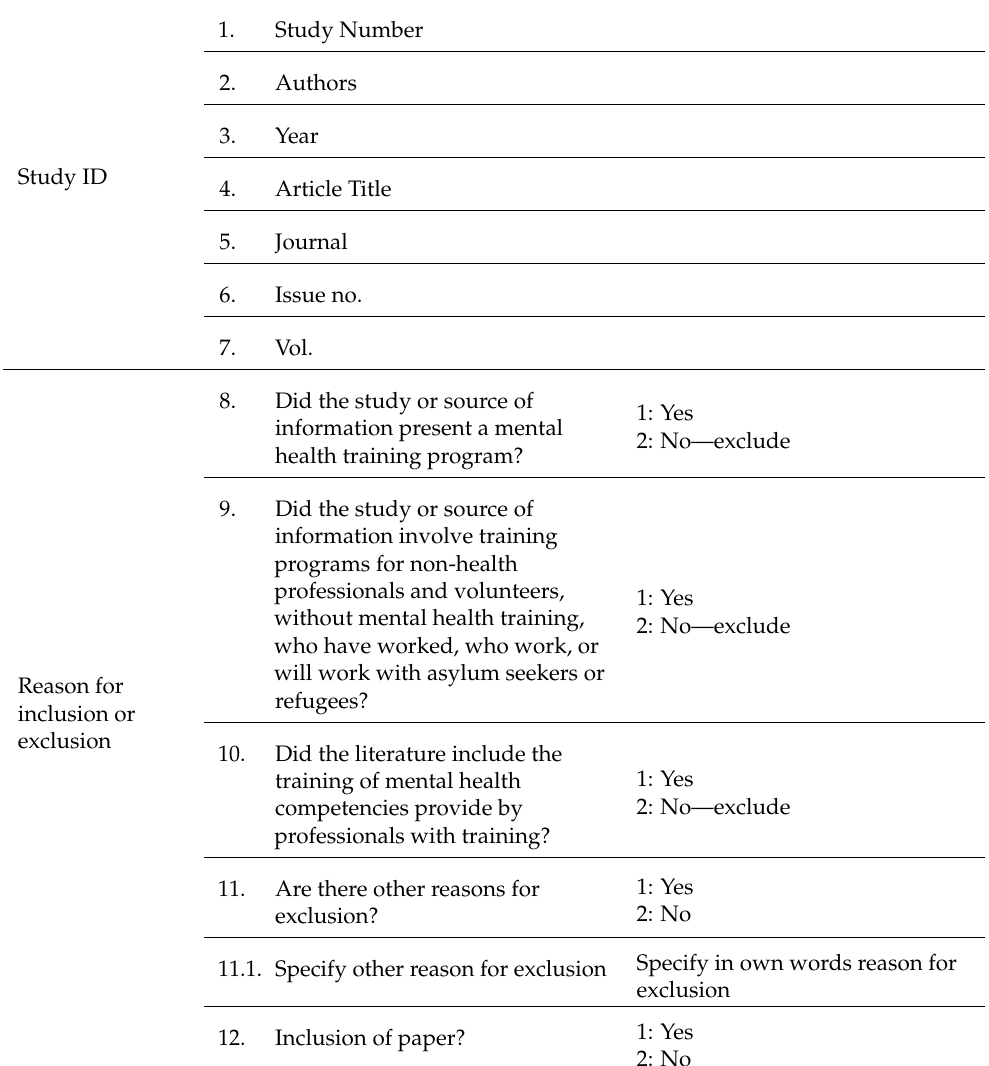
Table A2. Data Extraction